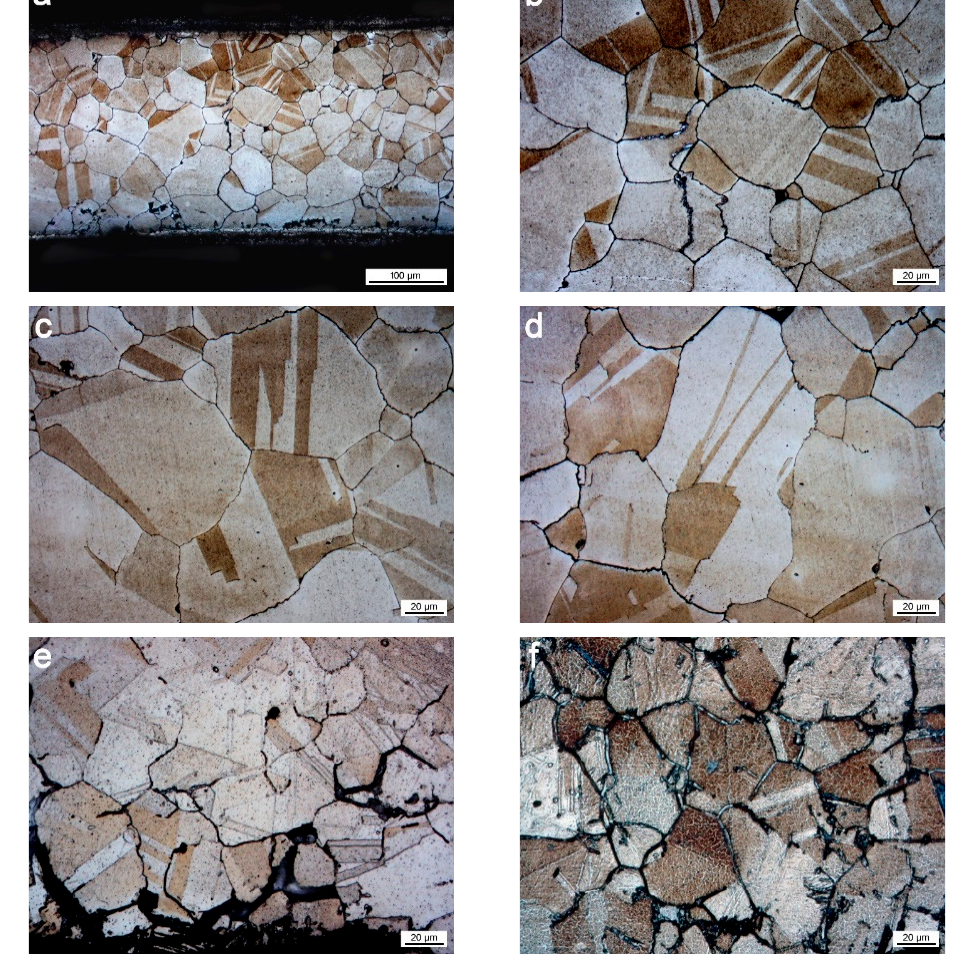
Figure 6. The ancient silver samples were etched by 1 mol/L ferric chloride solution (etching duration: 20 s), and impurities were removed by 1 mol/L sodium thiosulfate solution (for 120 s). ( a – d ) Ancient silver sample of the silver bowl excavated in Yiwu City; ( e , f ) ancient silver samples from Murong Zhi tomb.